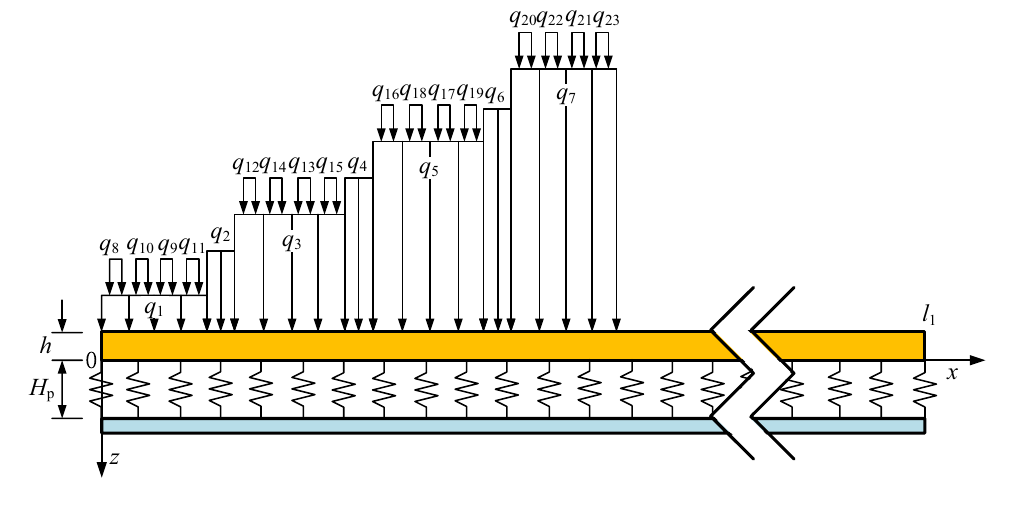
Fig. 8 Calculation model of the rib pillar compression under the static load of overlying strata and mining haul